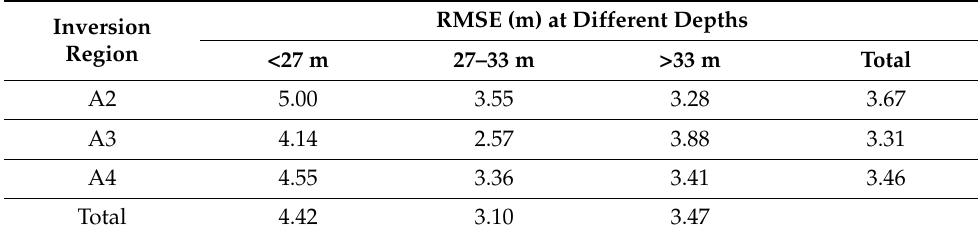
RMSE (m) at Different